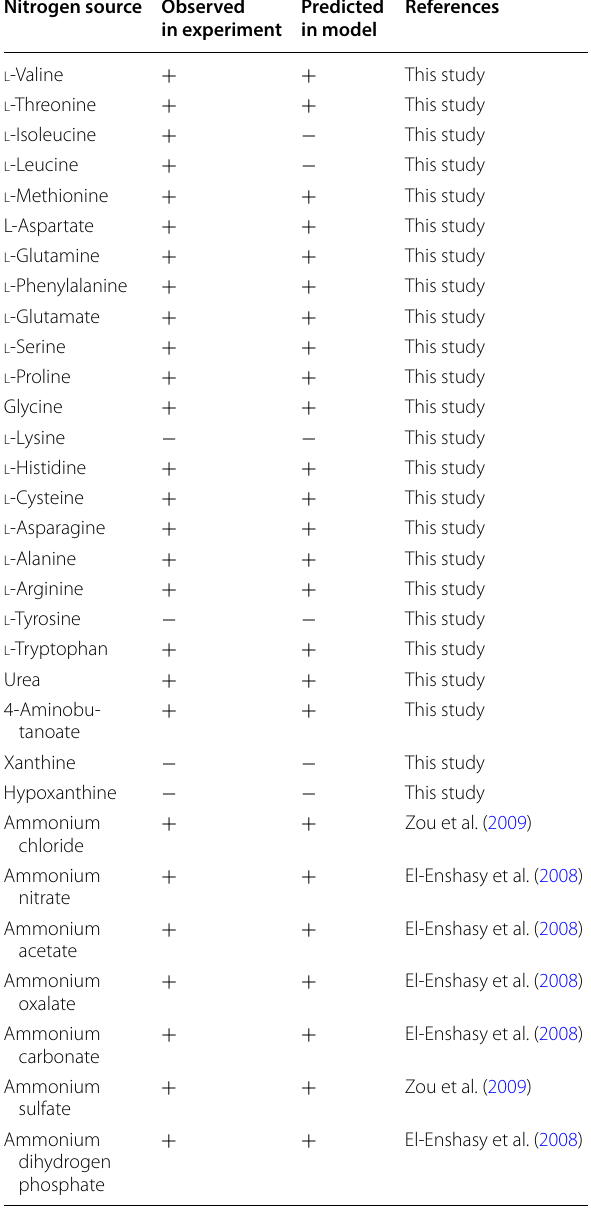
Table 2 Prediction of growth capability of iZZ1342 on different carbon sources ( represents non-growth) Carbon source